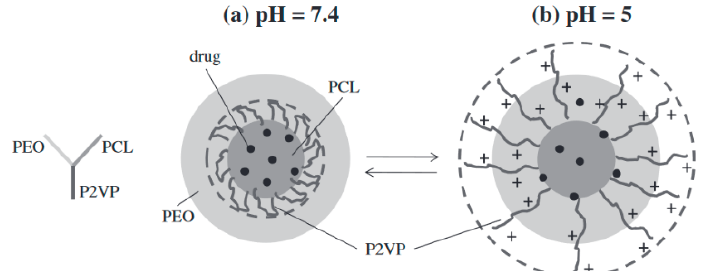
Figure 8. Schematic representation of the effect of ( a ) physiological pH and ( b ) acidic pH on the morphology of self-assembled PEG-PCL-P2VP micelles. Reprinted with permission from reference [29]. Copyright 2012 Elsevier.